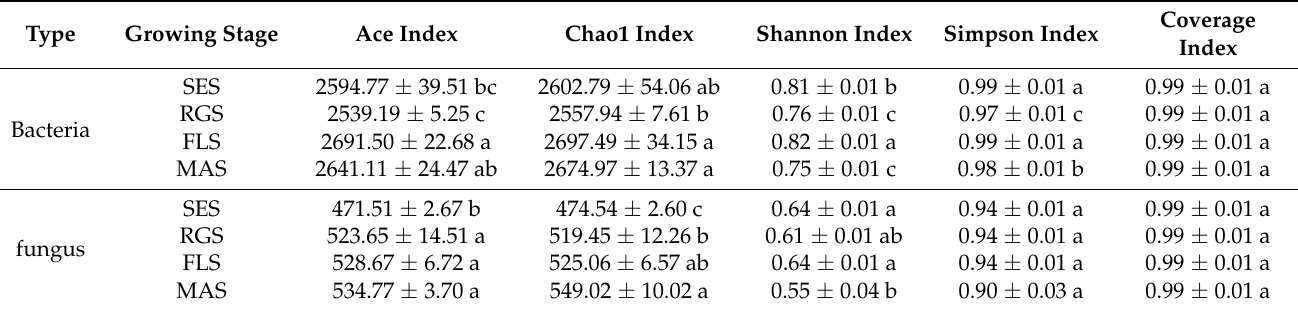
Table 5. Variations of microbial diversity index with different growth stages.